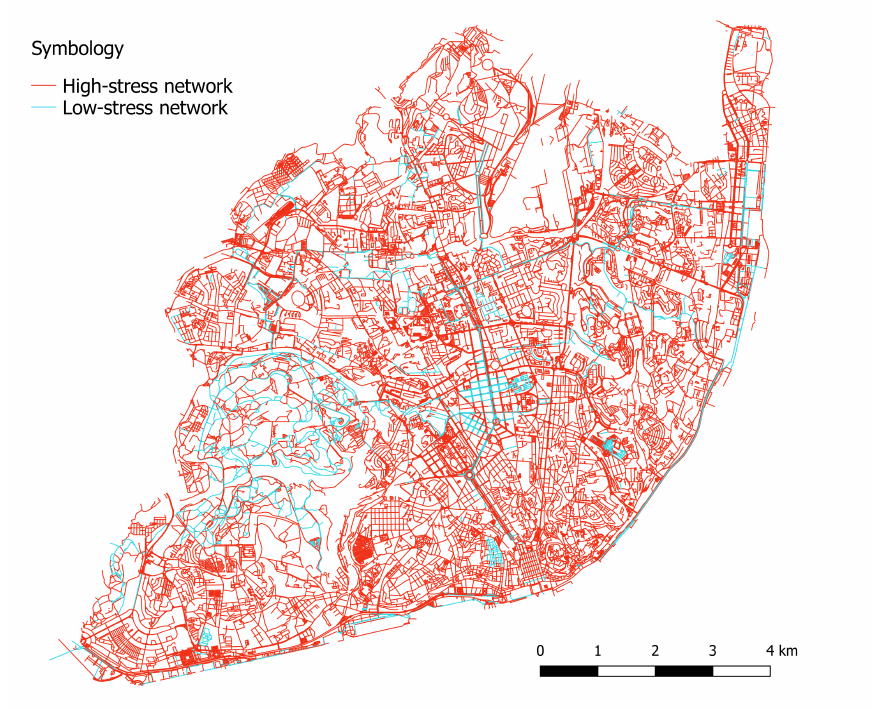
Figure 3. Stress network for study